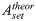
Behaviors of the motif 1 zero-order, antithetic, autocatalytic and motif 2 zero-order controllers with internal compensatory fluxes in response to an exponential increase in V and k3.Time/perturbation profiles of V and k3 are the same as in Fig 14. (a) Behavior of the motif 1 zero-order controller. Rate constant values as in Fig 18. Initial concentrations: A0 = 2.0, E0 = 4.0, V0 = 25.0, M0 = 4 × 109, N0 = 1 × 106. (b) Behavior of the antithetic controller. Rate constants as in Fig 20. Initial concentrations: A0 = 2.0, E1,0 = 0.25, E2,0 = 4.0, V0 = 25.0, M0 = N0 = O0 = 1 × 106, Q0 = P0 = 0.0. During phase 2 the controller shows a slight but constant offset below Asettheor. During phase 3 the controller breaks down when both V and k3 increase exponentially. (c) Behavior of the autocatalytic controller. Rate constants are as described in Fig 22. Initial concentrations: A0 = 2.0, E0 = 4.0, V0 = 25.0, M0 = 4 × 109, N0 = 1 × 107. During autocatalytic growth only (phase 2) the autocatalytic controller is able to move Ass precisely to Asettheor, but shows an offset from Asettheor when both k3 and V increase exponentially). (d) Behavior of the motif 2 based controller (Eqs 62–66). Rate constants and initial conditions as in Fig 24. Note the significant overcompensation (offset above Asettheor) during phase 2, but the return to Asettheor (=k9/k8) when k3 starts to grow exponentially.